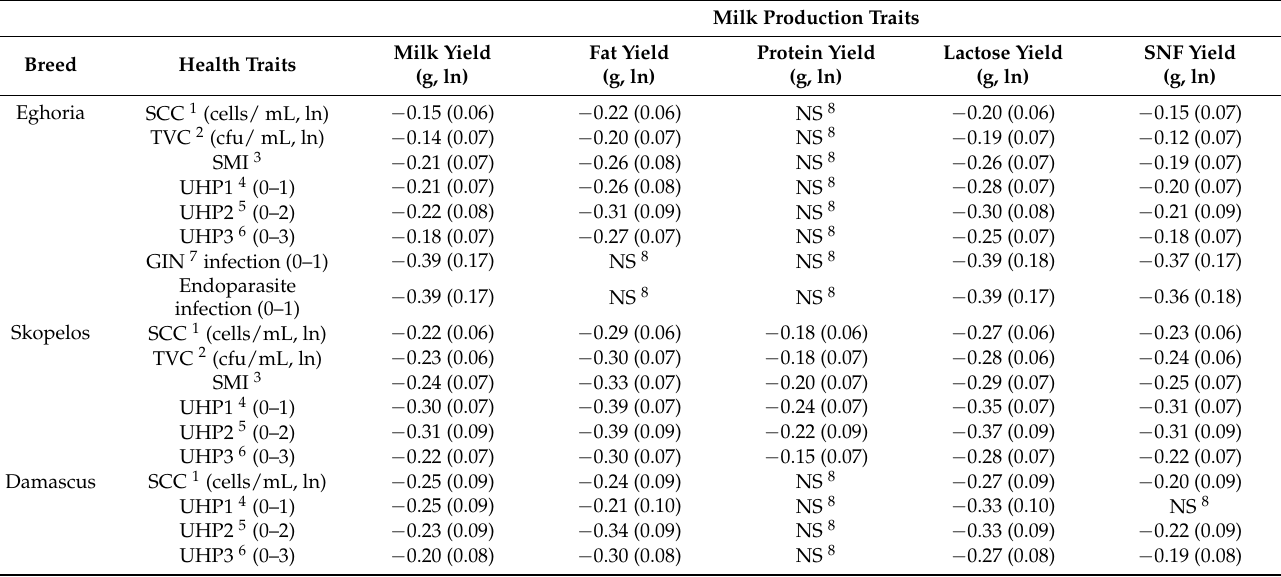
Table 7. Statistically significant ( p < 0.05) animal correlations (standard error in parentheses) between health and milk production traits in Eghoria, Skopelos, and Damascus goats. Milk Production